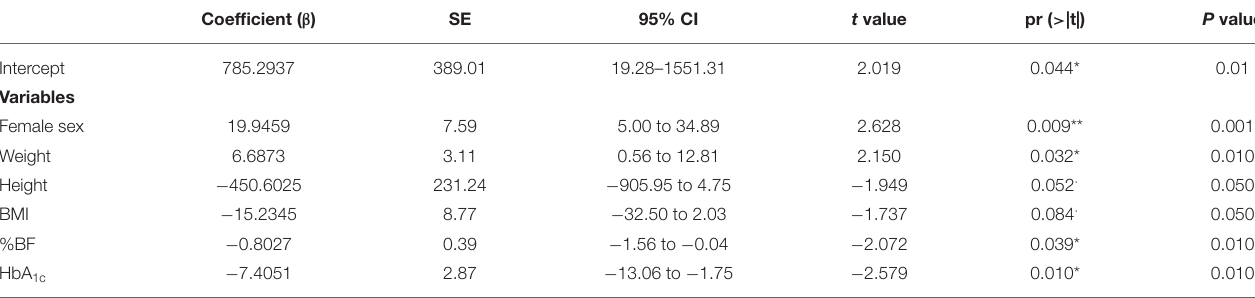
TABLE 4 | Associations among selenium intake and explanatory variables, determined by multiple regression model adjusted by the backward strategy ( n = 267). Coefficient ( β )